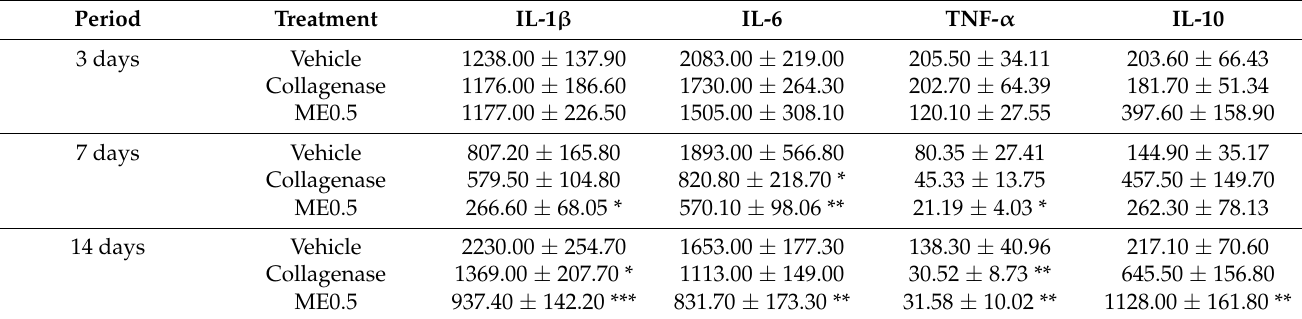
Table 3. Levels of IL-1 β , IL-6, TNF- α , and IL-10 in skin wounds after 3, 7, or 14 days of treatment with vehicle, collagenase cream, or